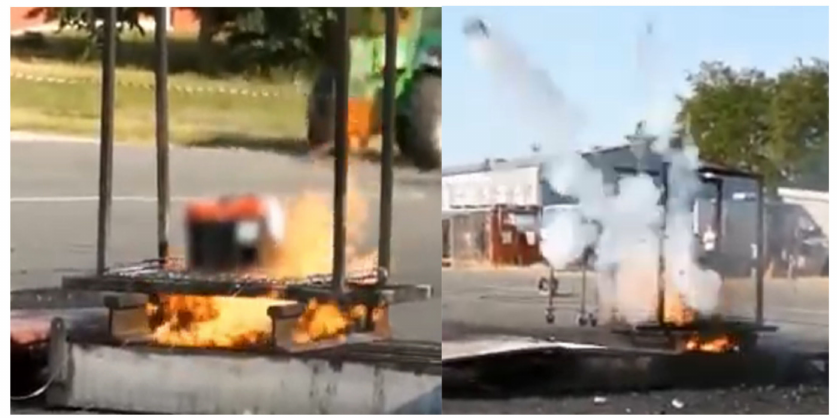
Figure 22. Exp. A.8